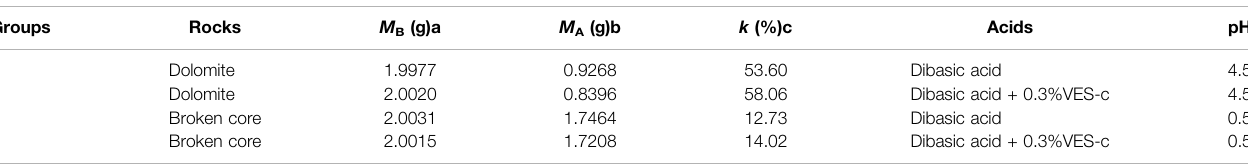
TABLE 1 | Results of four acid – rock reaction groups.